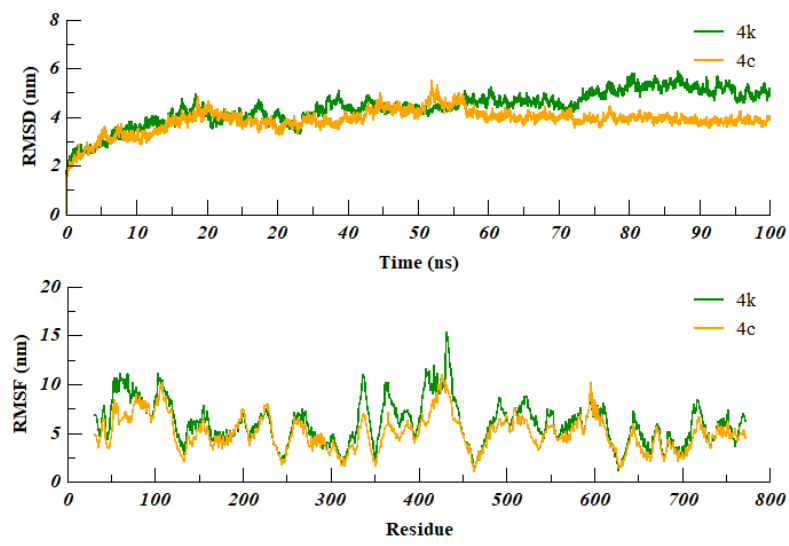
Figure 7. RMSD and RMSF plot of 4c and 4k in complex with RdRp of SARS-CoV-2 over the 100ns of simulation.